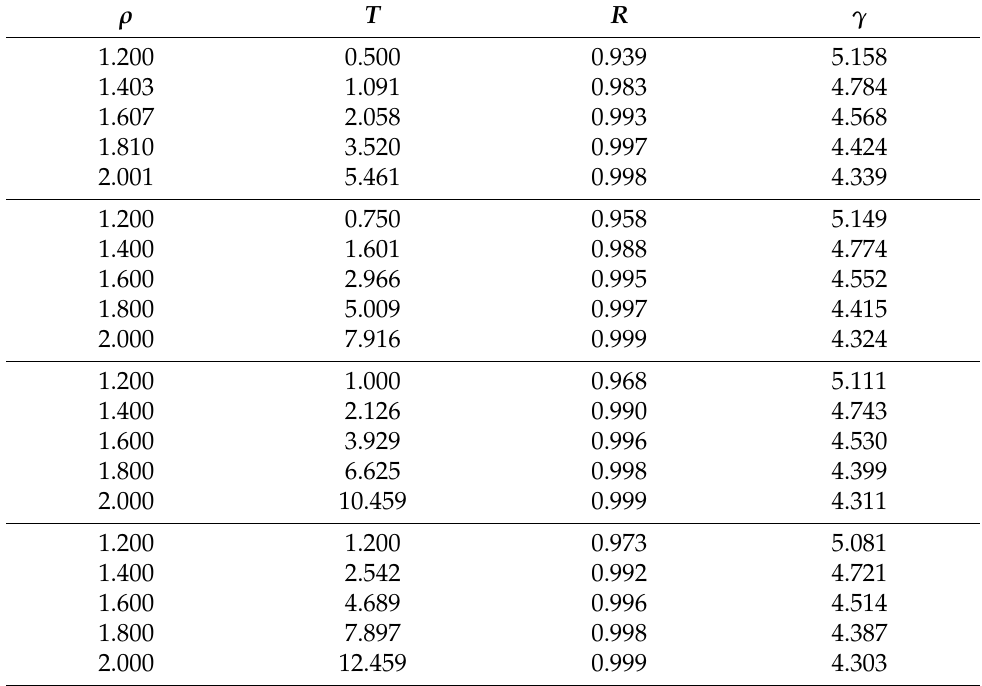
Table A3. Selected KA state points of the four isomorphs (Figures 6–8).